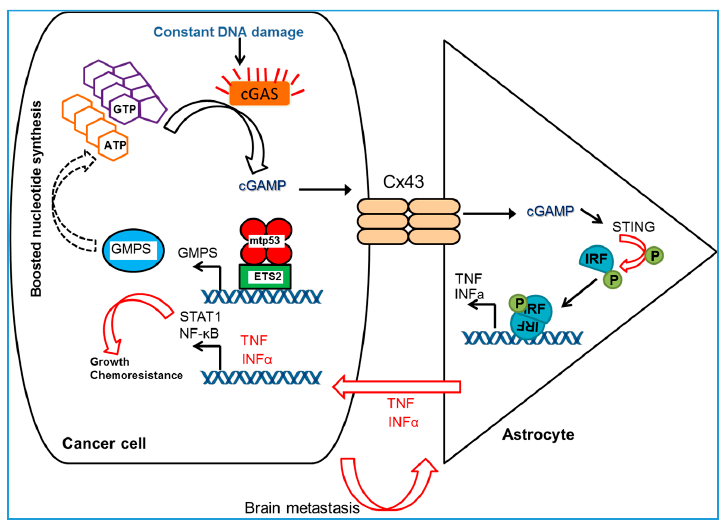
Figure 2. Schematic showing the mechanisms of cancer cells metastasis in brain. Adapted and modified from Chen et al. [90].